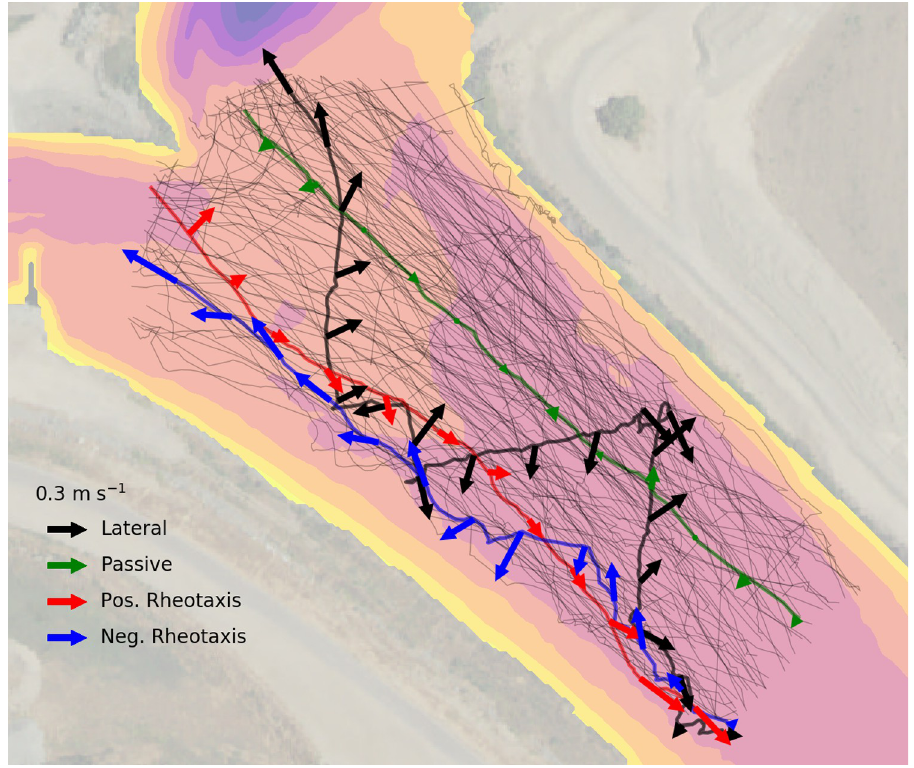
Fig 4. Fish tracks and behavior examples. All valid tracks within the analysis region (light lines), with four individuals highlighted as examples of specific behaviors. All tracks represent downstream movement from the lower right to the upper left. Background contours show